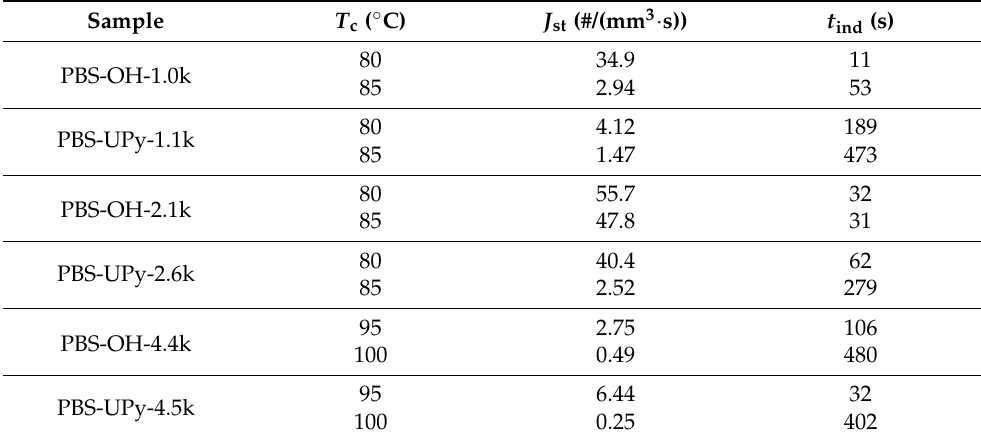
Figure 8. Dependence of primary nucleation density on crystallization time for PBS-OH-1.0k and PBS-UPy-1.1k ( A ), PBS-OH-2.1k and PBS-UPy-2.6k ( B ) and PBS-OH-4.4k and PBS-UPy-4.5k ( C ) at various temperatures. Table 3. The steady-state nucleation rate ( J st ) and induction time of nucleation ( t ind ) of PBS-OH and PBS-UPy samples at various crystallization temperatures.